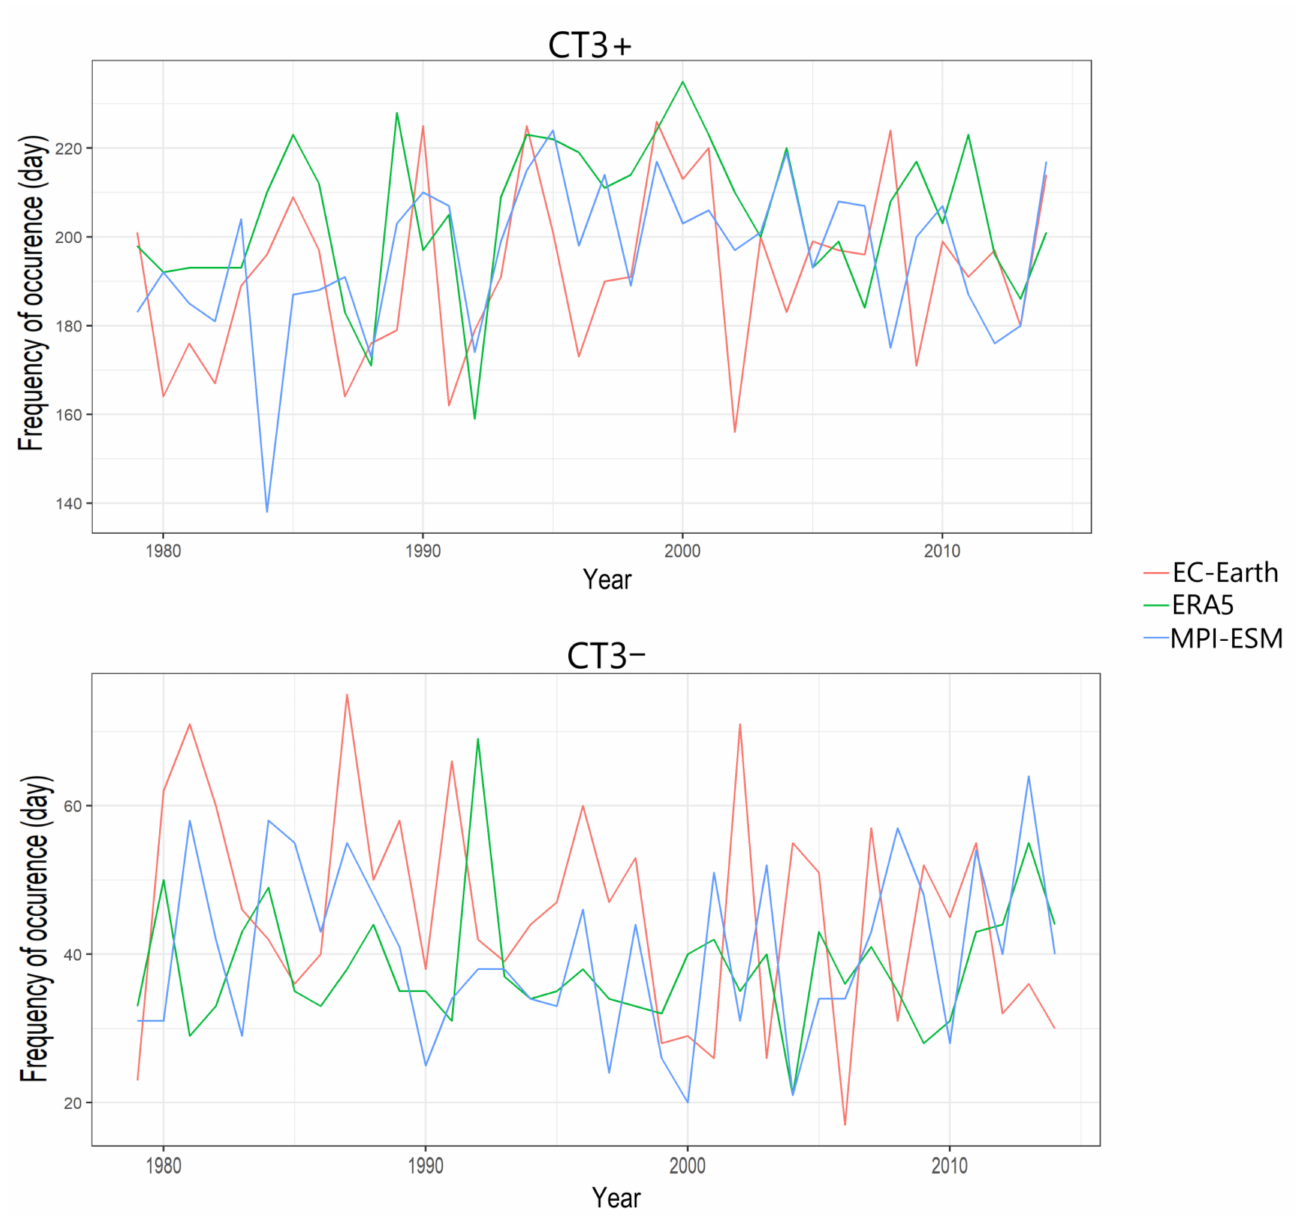
Figure 10. Validation of the annual frequency of occurrence of CT3+ and CT3 − as simulated from the GCMs compared to ERA5 for the 1979–2014